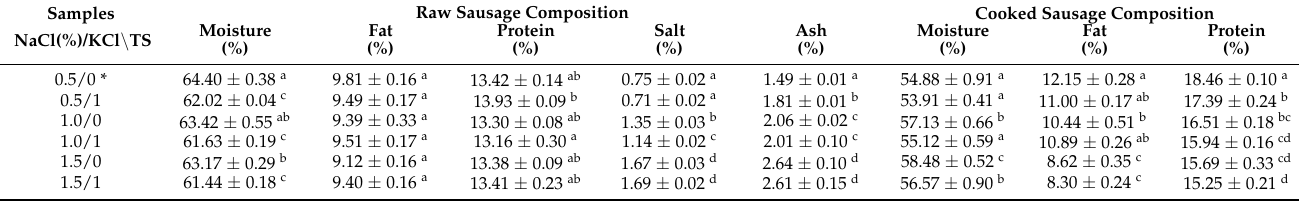
Table 2. Proximate composition of raw or cooked breakfast sausages manufactured using pork belly high pressure treated at 150 MPa containing different salt levels (NaCl) and added ingredients (KCl \ TS)